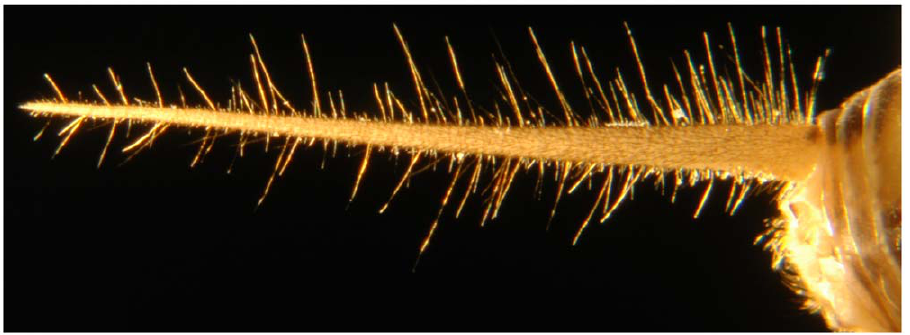
Figure 1. The cercus of AchetaDomestica with filiform hairs clearly visible. The length of the cercus is approximately 1 cm.